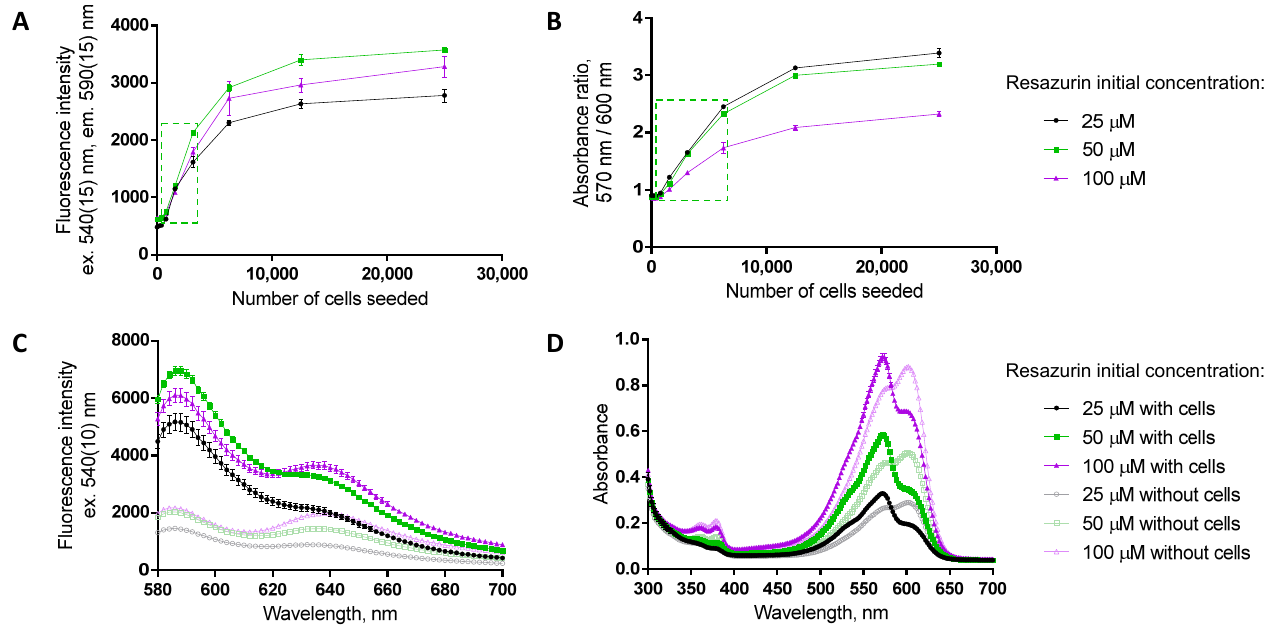
Figure 2. Optimization of the detected optical characteristic and resazurin concentration. ( A , B ) Dynamic range studies in T98-G cells, at 72 h post-seeding; initial concentration of resazurin indicated in the legend on the right (assay duration in the presence of resazurin: 2 h). The green dashed box indicates the linear dependence of the assay readout on the number of seeded cells for a 50 μ M initial concentration of resazurin. ( C , D ) Fluorescence and absorbance spectra of resazurin solutions (initial concentration of resazurin indicated in the legend on the right) after 2 h assay duration in the absence or presence of T98-G cells (at 72 h post-seeding, initial seeding density of 3125 cells/well) on the 96-well plate. In each graph, average of duplicates ± SEM from a single representative experiment is shown.